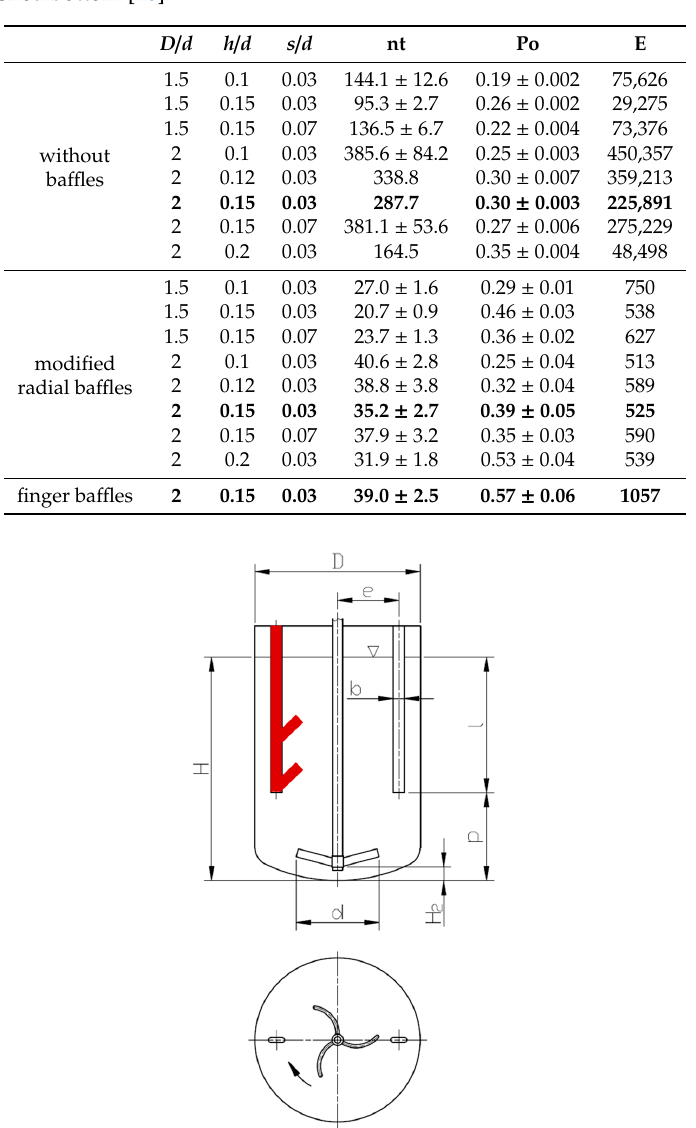
Figure 8. Cylindrical vessel with a dished bottom equipped with finger (shown in red) or radial baffles (shown in outline) and an impeller with curved blades.